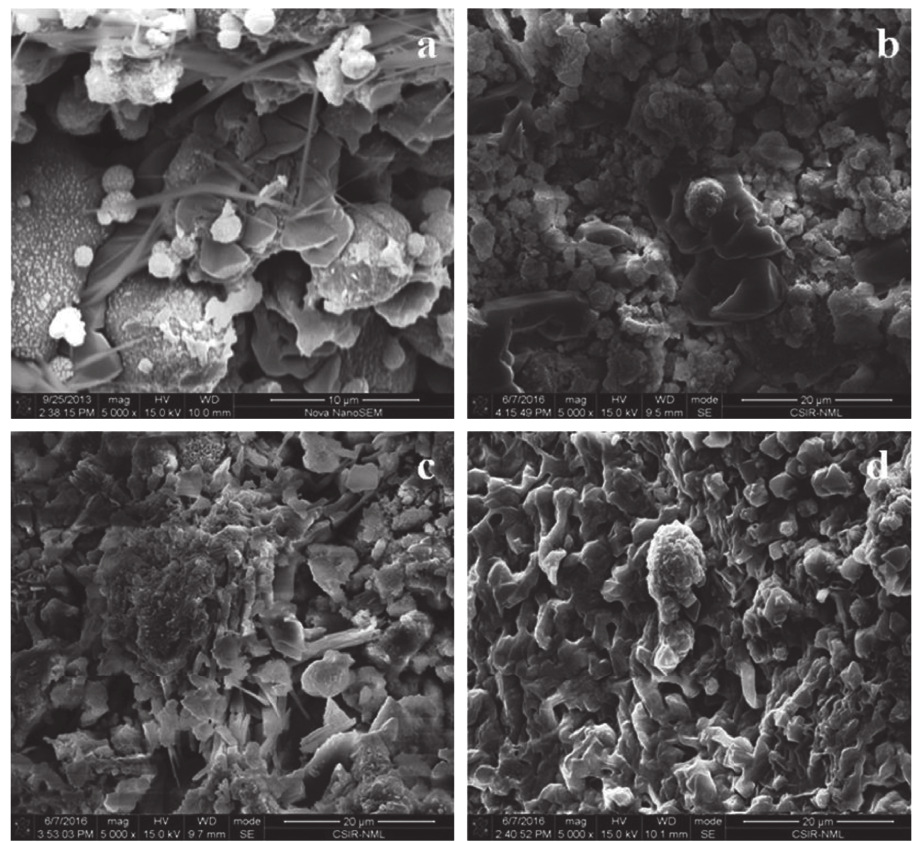
Figure 8: Morphology of fly ash-zinc composite geopolymer. (a) 100% fly ash. (b) 60% fly ash and 40% zinc slag. (c) 20% fly ash and 80% zinc slag. (d) 100% zinc slag. Data from